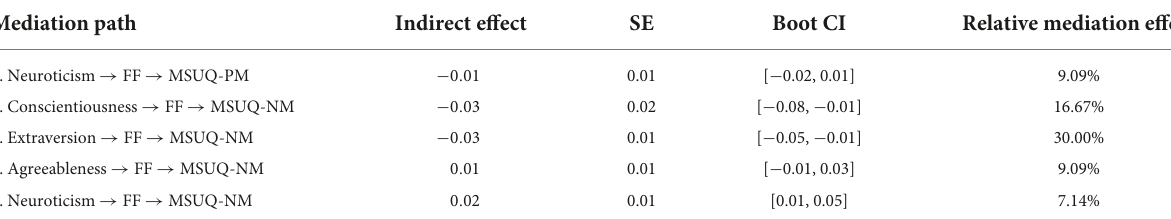
TABLE 2 Mediating effect of family